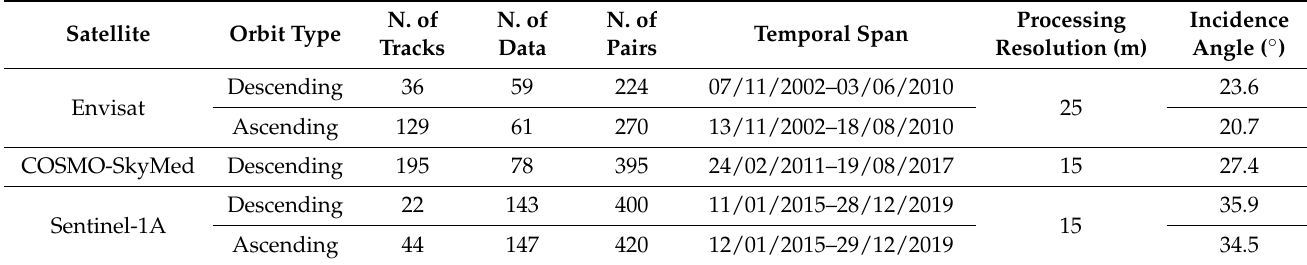
Table 1. Main characteristics of the datasets used in the multitemporal interferometric processing.